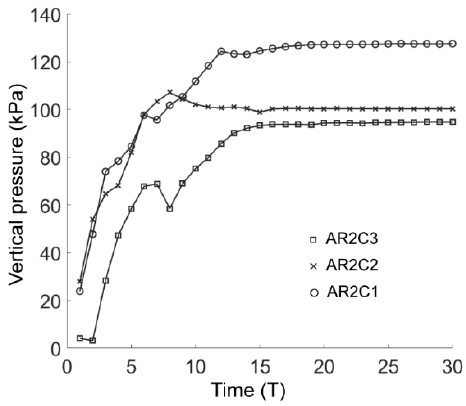
Figure 32. Average vertical pressure on the tunnel lining as a function of computational time in all three cases of AR = 0.7.